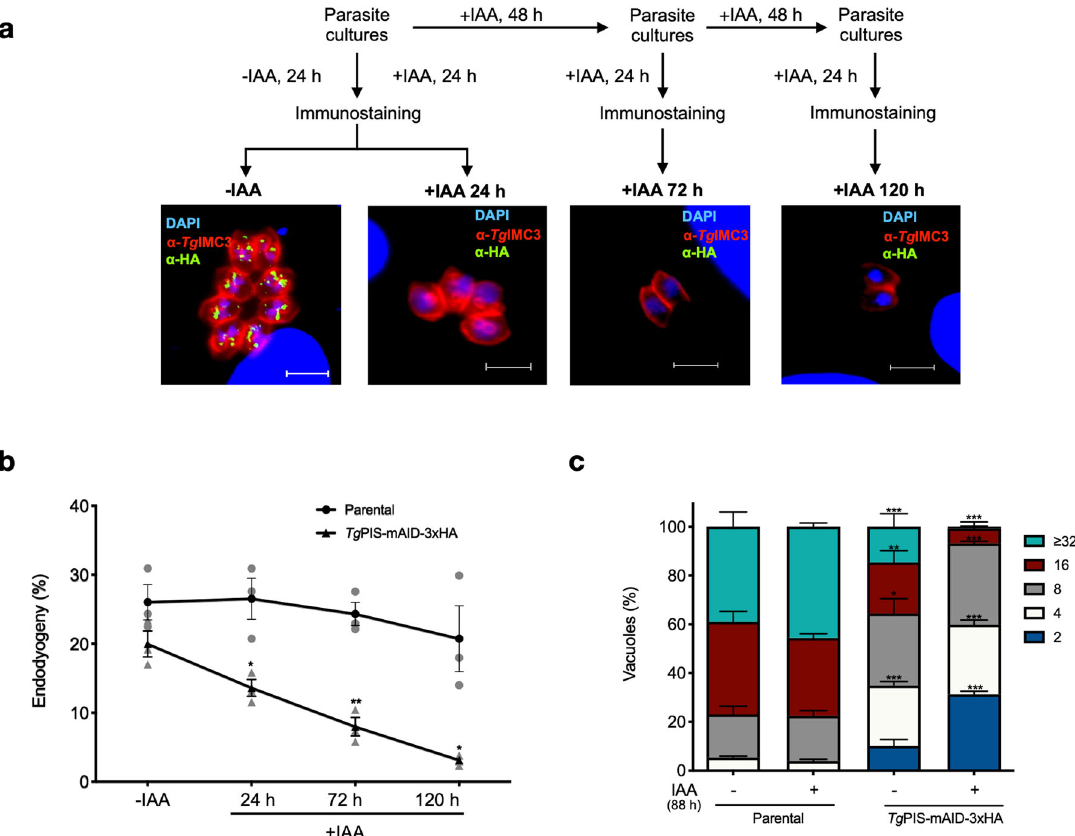
Fig. 5 Depletion of Tg PIS impairs the cell division in tachyzoites. a Immunostaining of the budding daughter cells (endodyogeny) in the Tg PIS-mAID- 3xHA strain precultured without or with auxin. Intracellularly-developing tachyzoites were treated with 500 μ M IAA or with 0.1% ethanol (-IAA), as schematized. Samples were stained with α -HA (green) to monitor the downregulation of Tg PIS, and with α - Tg IMC3 (red) to visualize the endogeny. Shown are the representative images of Tg PIS-mAID-3xHA mutant. b Quanti fi cation of tachyzoites harboring the progeny. A total of 400 – 500 vacuoles with IMC3-positive daughter cells were scored for each condition ( n = 3 assays). c Proliferation rate of the Tg PIS-mAID-3xHA mutant with respect to its parental strain. Parasites were precultured with 500 µ M IAA ( + IAA) or 0.1% ethanol (-IAA) for 48 h and subjected to the replication assay (40 h infection). Graphs show the mean percentage of vacuoles containing speci fi ed number of parasites. A total of 400 – 500 vacuoles for each condition were scored ( n = 3 assays, mean ± S.E; * p ≤ 0.05; ** p ≤ 0.01; *** p ≤